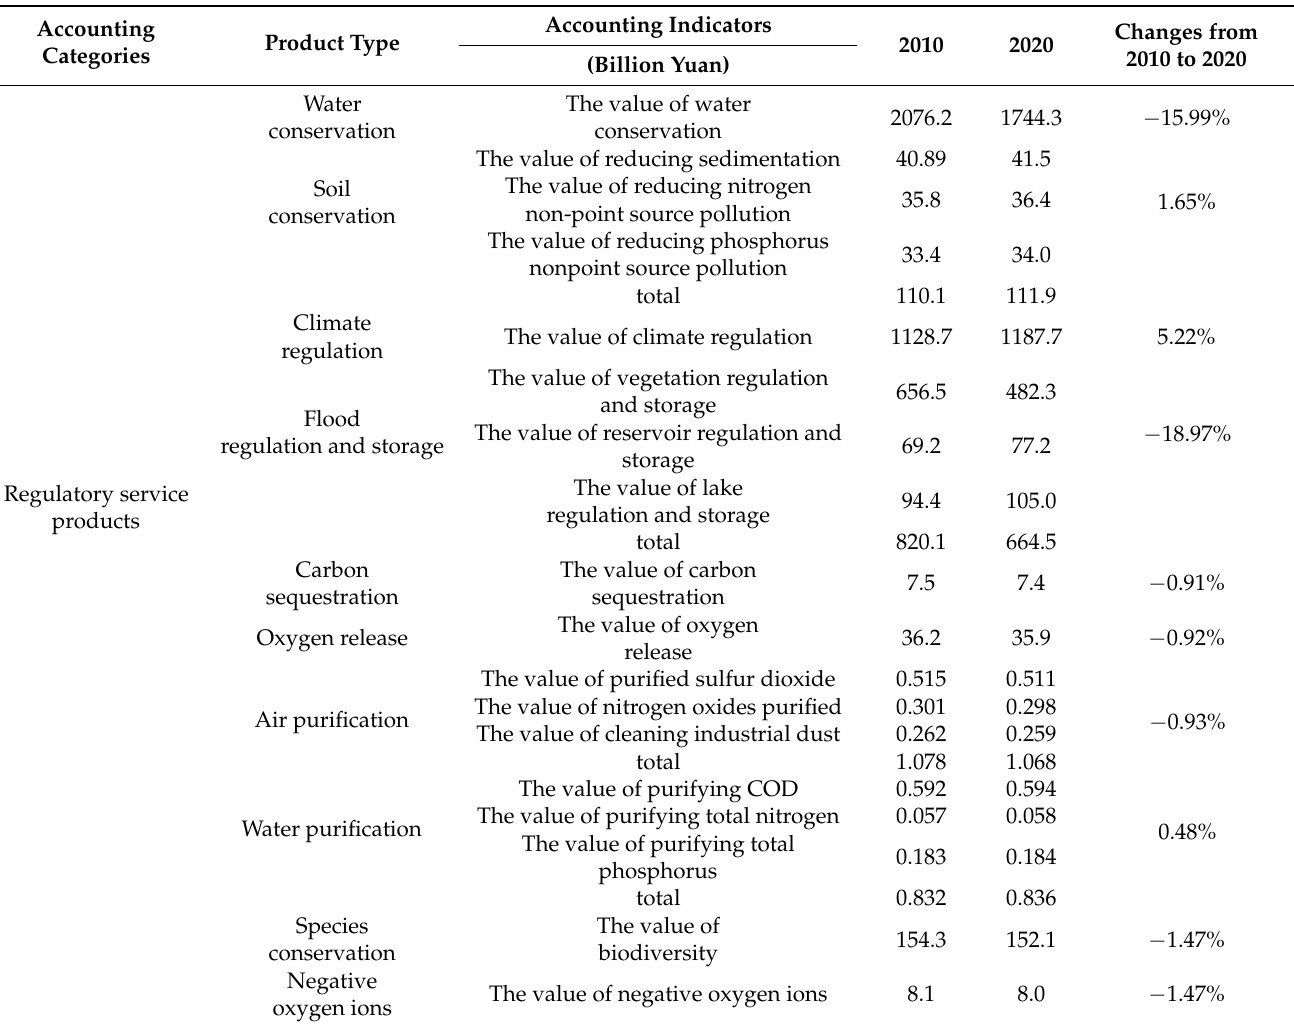
Table 6. The value of regulatory service products in Jiangxi Province